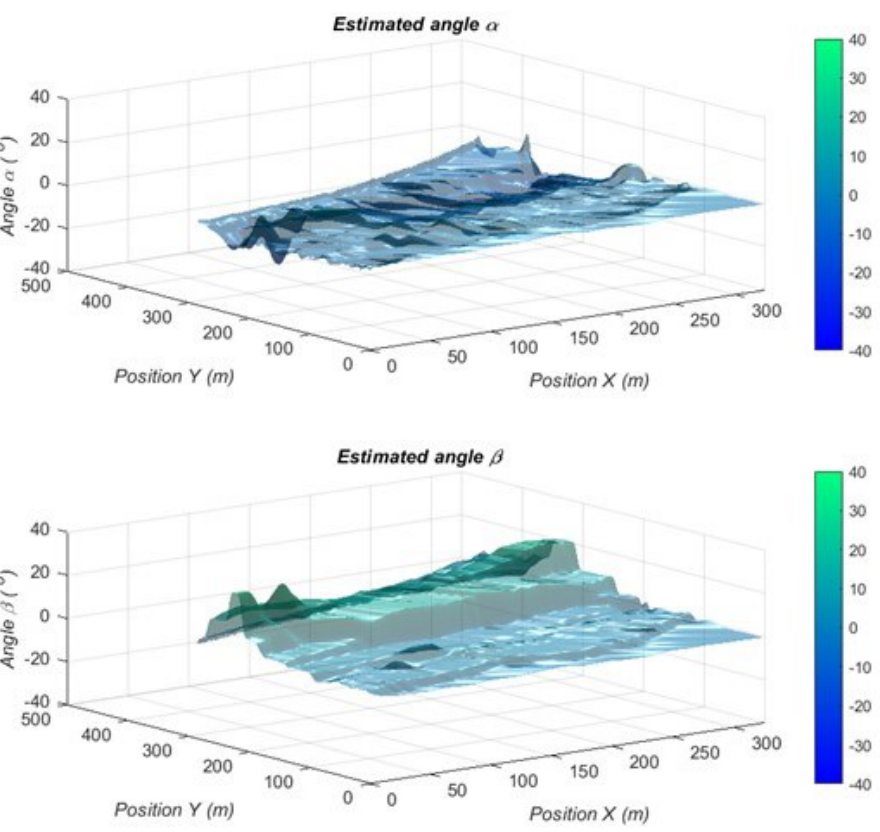
Figure 16. Estimated sea-bottom slope angles in the x ( α ) and y ( β ) axes in the experimental area based on experimental